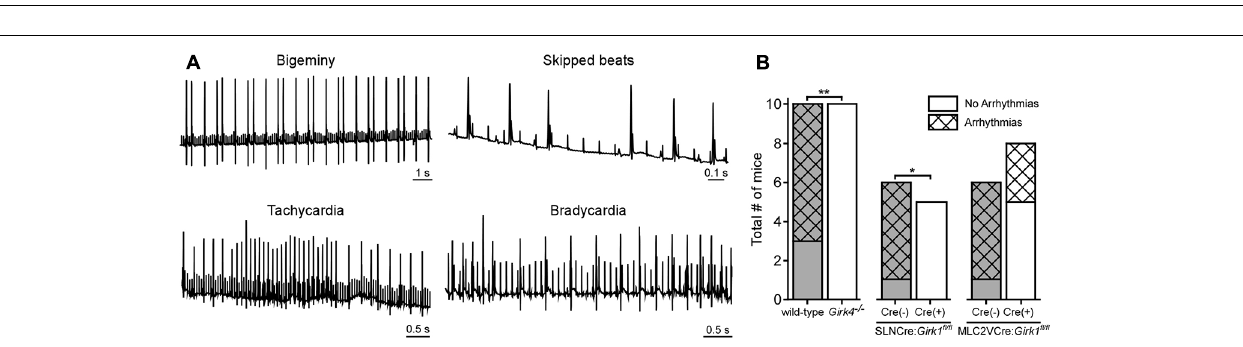
FIGURE 5 | Impact of whole-heart and tissue-specific GIRK channel ablation on VNS-induced increase in HRV. (A) Typical RR tachograms extracted from ECG recordings while VNS was on, comparing beat-to-beat changes in RR intervals between SLNCre(–): Girk1 fl / fl (Top) and SLNCre(+): Girk1 fl / fl (Bottom) mice. (B) Summary of mean HRV data at baseline and during VNS. Two-way ANOVA analysis revealed an interaction between genotype and treatment between wild-type ( n = 8) and Girk4 − / − ( n = 10) mice ( F 1 , 16 = 20.3; P < 0.001), and between SLNCre(–): Girk1 fl / fl ( n = 6) and SLNCre(+): Girk1 fl / fl ( n = 5) mice ( F 1 , 9 = 12.8; P < 0.01). There was a significant main effect of treatment ( F 1 , 12 = 44.0; P < 0.001) between MLC2VCre(–): Girk1 fl / fl ( n = 6) and MLC2VCre(+): Girk1 fl / fl ( n = 8) littermates, but no main effect of genotype ( F 1 , 12 = 4.2; P = 0.06) or interaction between genotype and treatment ( F 1 , 12 = 3.2; P = 0.10). Symbols: ∗ P < 0.05, ∗∗ P < 0.01, and ∗∗∗ P < 0.001, vs. PRE (within genotype); ### P < 0.001, wild-type vs. Girk4 − / − (within treatment); ## P < 0.01, SLNCre(–): Girk1 fl / fl vs. SLNCre(+): Girk1 fl / fl (within treatment). (C) Summary of mean HRV data at baseline and during VNS, following atropine administration. In wild-type ( n = 4) and Girk4 − / − ( n = 6) mice, there was a main effect of treatment ( F 1 , 8 = 5.7, P < 0.05), however, post hoc analysis did not reveal any significance within either genotype. There was no main effect of genotype ( F 1 , 8 = 2.0, P = 0.19), or interaction between genotype and treatment ( F 1 , 8 = 3.2; P = 0.11), in wild-type and Girk4 − / − mice as well. There was no main effect of treatment ( F 1 , 8 = 0.1, P = 0.76) or genotype ( F 1 , 8 = 0.53, P = 0.49), and no interaction between treatment and genotype ( F 1 , 8 = 3.5, P = 0.1), in SLNCre(–): Girk1 fl / fl ( n = 6) and SLNCre(+): Girk1 fl / fl ( n = 4) mice. There was no main effect of treatment ( F 1 , 7 = 0.45, P = 0.52) or genotype ( F 1 , 7 = 0.79, P = 0.40), and no interaction between treatment and genotype ( F 1 , 7 = 0.3; P = 0.62), in MLC2VCre(–): Girk1 fl / fl ( n = 6) and MLC2VCre(+): Girk1 fl / fl ( n = 4) mice.